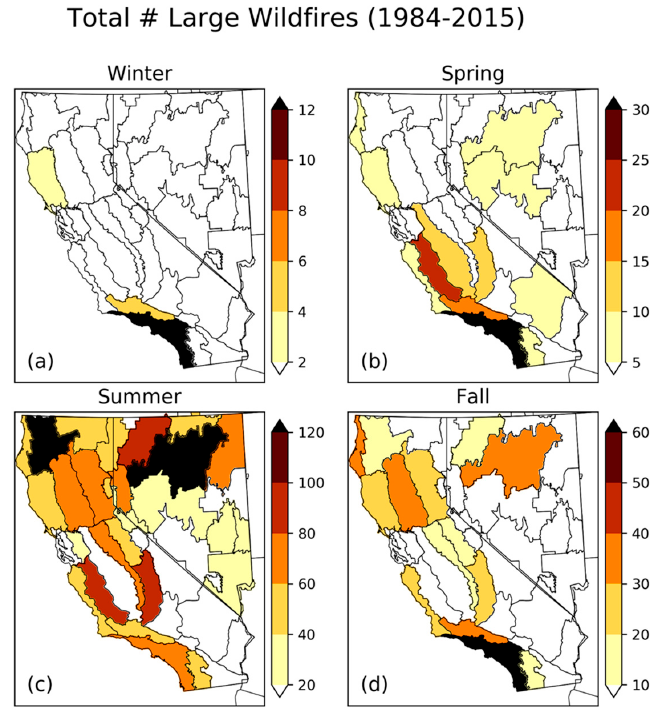
Figure 1. Total number of large wildfires (>1000 acres burned) for ( a ) winter, ( b ) spring, ( c ) summer, and ( d ) fall across the period 1984–2015 for each Predictive Service Area (PSA) in California and Nevada. Note the scale changes for each season.